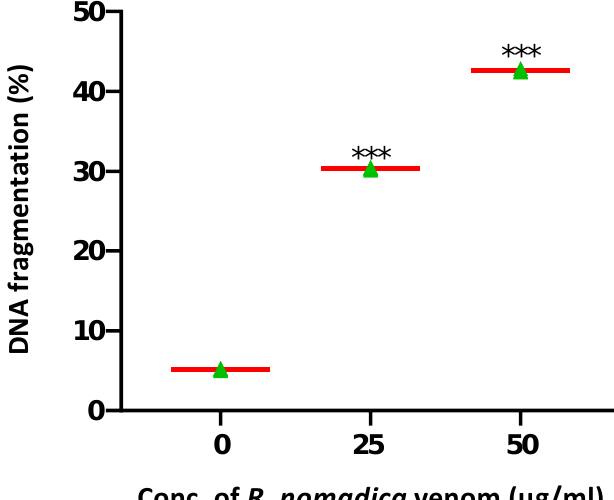
Figure 6. Quantitative estimation of DNA fragmentation by diphenylamine (DPA) assay in treated HepG2 cells with two different concentrations of R. nomadica venom (25–50 μg/mL) and untreated cells. Data are analyzed with one-way ANOVA followed by Tukey’s test. Values are represented as mean ± SEM. *** denotes significance difference ( p < 0.001) vs. control.